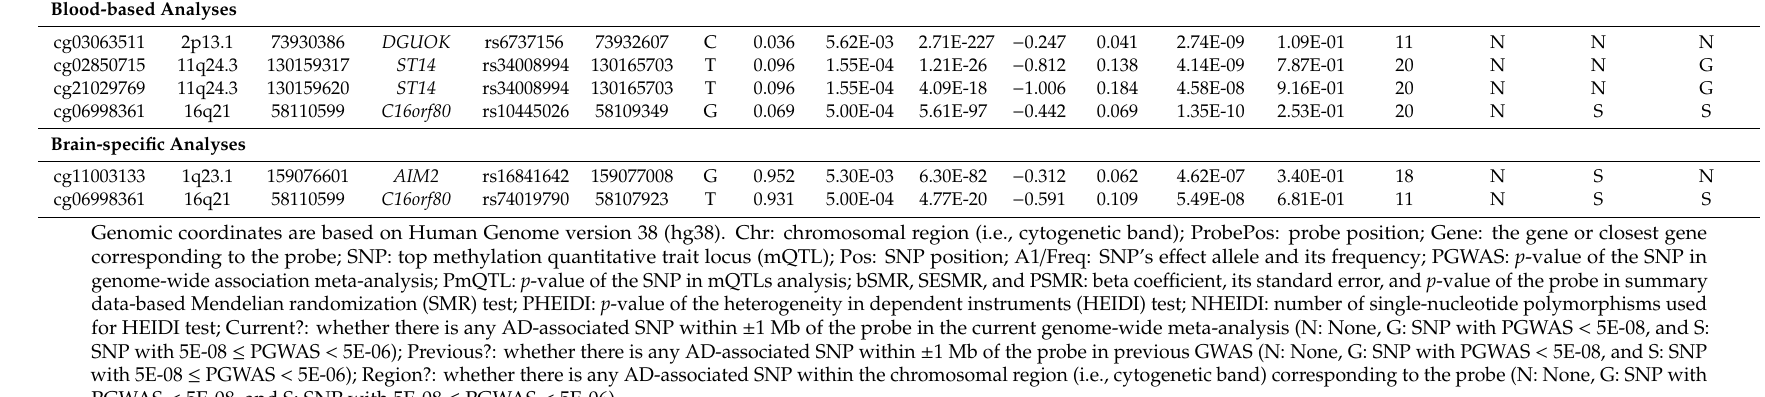
Table 3. Methylome-wide association results for the four genes that had epigenetically and transcriptionally AD-associated probes.